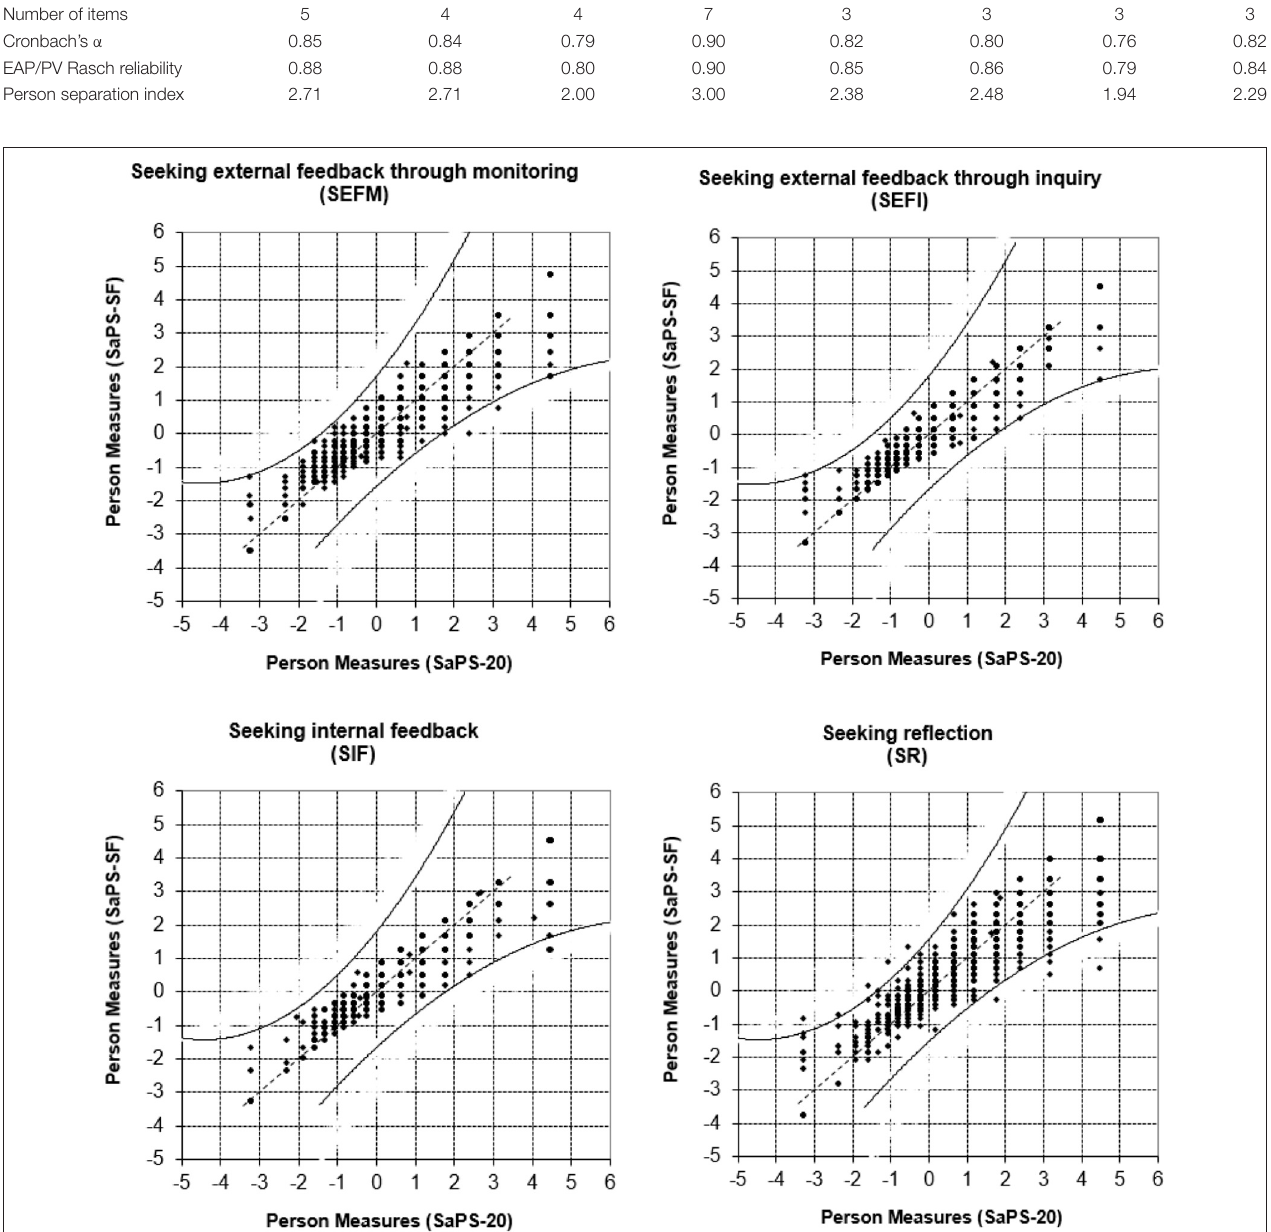
FIGURE 5 | Person measure invariance (SaPS-SF vs.